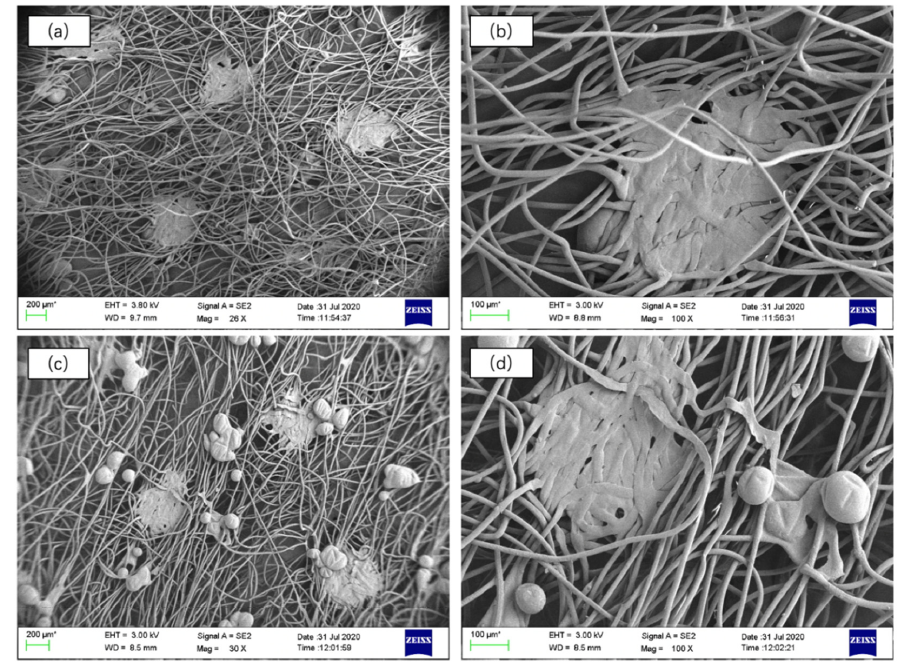
Figure 3. SEM images of polyamide nonwoven veil. ( a , b ) smooth side, ( c , d ) rough side.